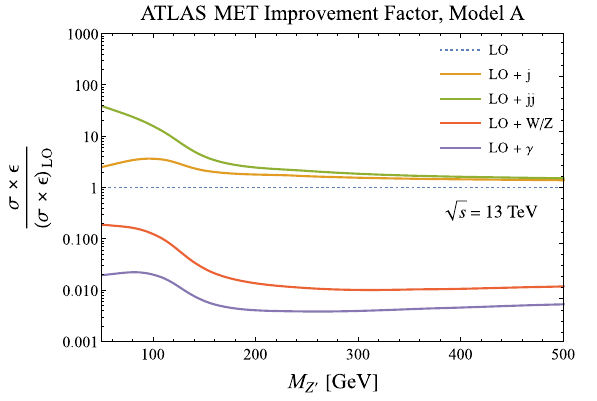
Fig. 55 (Figure 4 from [228]) Cross section times efficiency of var- ious processes (leading order, 1-jet ISR, 2-jet ISR, electro weak ISR) scaled by their respective leading order process. The left plot uses the (cid:3) E T (here called MET) trigger and Model A which has a dark pion life- time of 150 mm. The right uses the H T trigger and Model B which has a